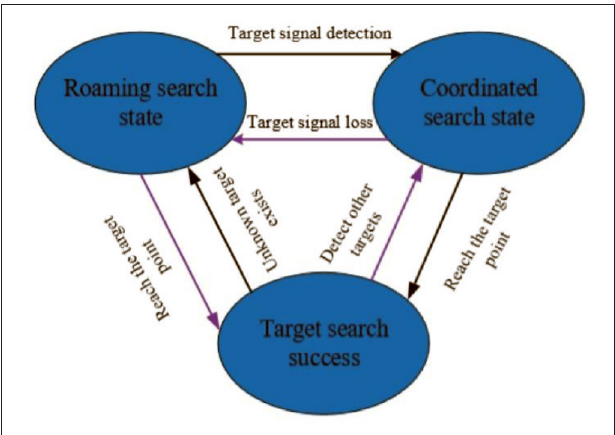
FIGURE 1 | Multi-target search algorithm framework